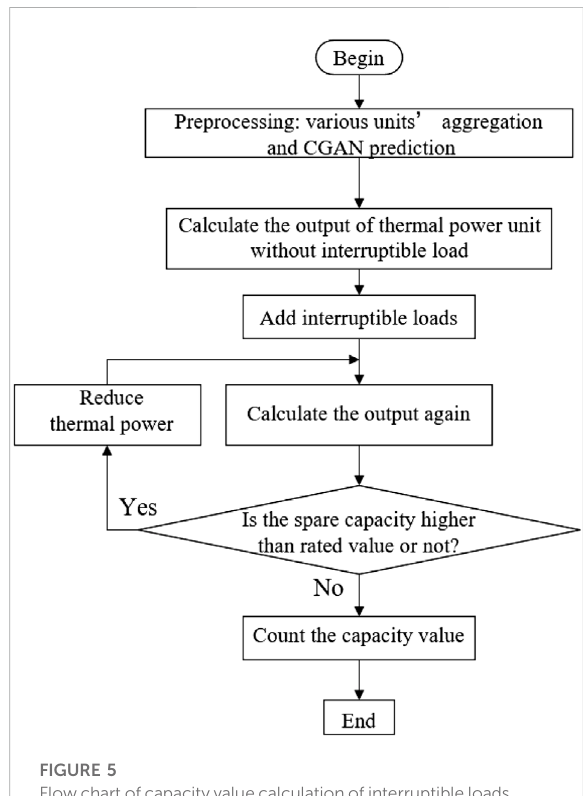
FIGURE 5 Flowchart